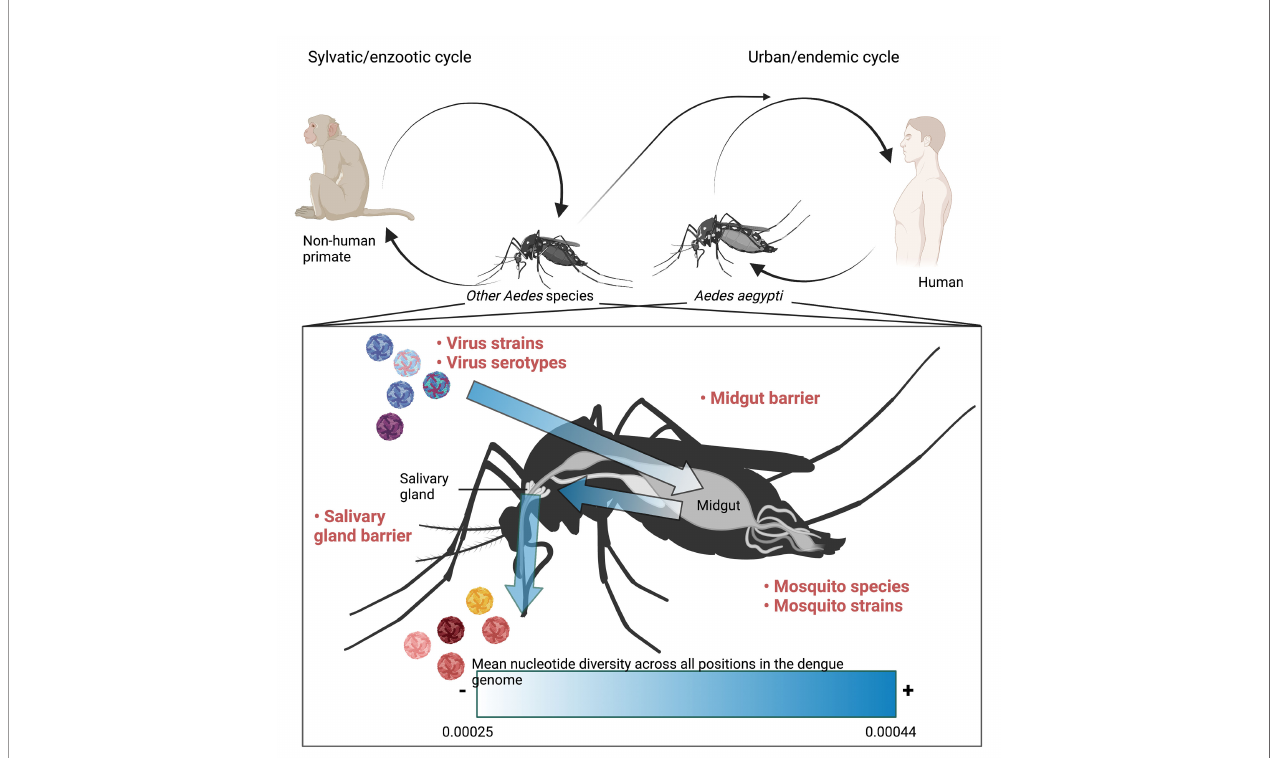
FIGURE 1 | Schematic depicting dengue transmission among non-human primates and Aedes species in the sylvatic cycle and among humans and Aedes aegypti in the urban cycle as well as the transmission between the two cycles. The immune/genome diversity barriers imposed by anatomical features of Aedes mosquito species are further depicted. Arrows highlight the path of infection taken by DENV following an infected blood meal. Factors that in fl uence the diversity of a quasispecies are written in bold red text. Arrows are shaded darker in areas where the mean nucleotide diversity across the DENV genome is higher whereas the lighter shade represents anatomical regions that are known to impose infection/genome diversity barriers and have a lower mean nucleotide diversity as determined by Lequime et al., 2016 (Lequime et al., 2016). The image was composed using